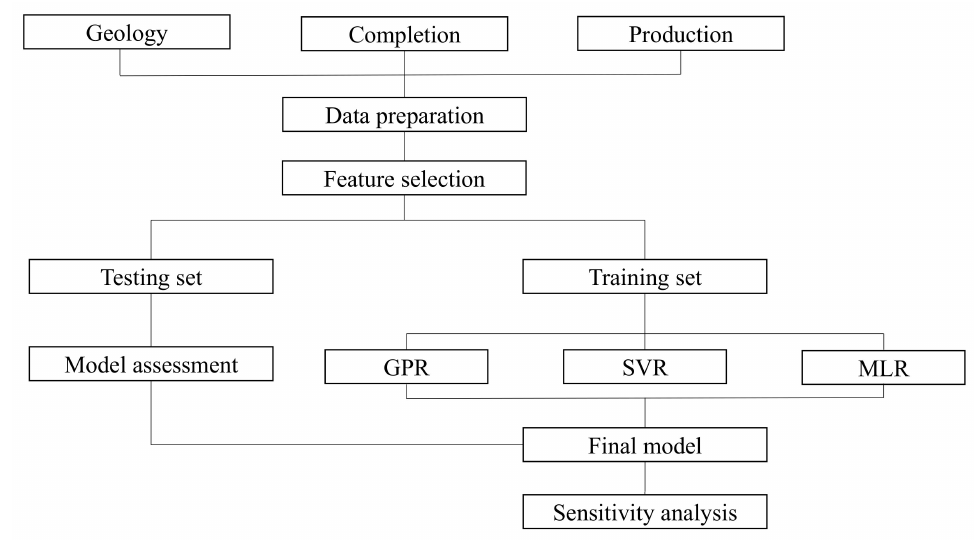
Figure 1. Flowchart of the research